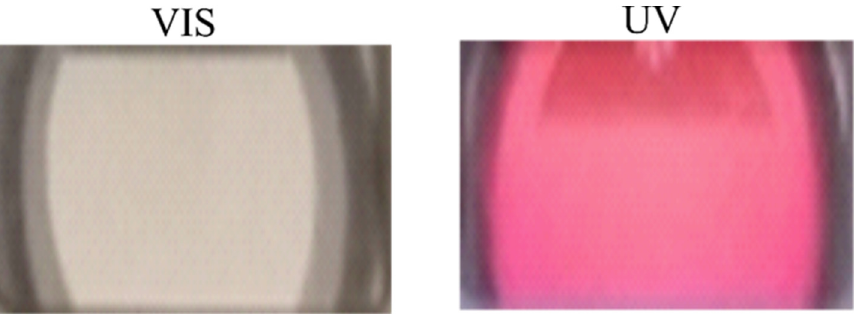
Figure 4. Effect of illumination on the P (TEGA-co-SPA) liquid film color. The photos were taken by a normal camera on the top of the QCM-D window cell.